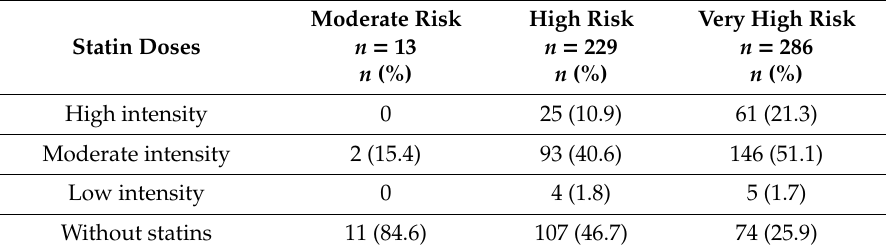
Table 4. Use of the di ff erent statin schemes according to population